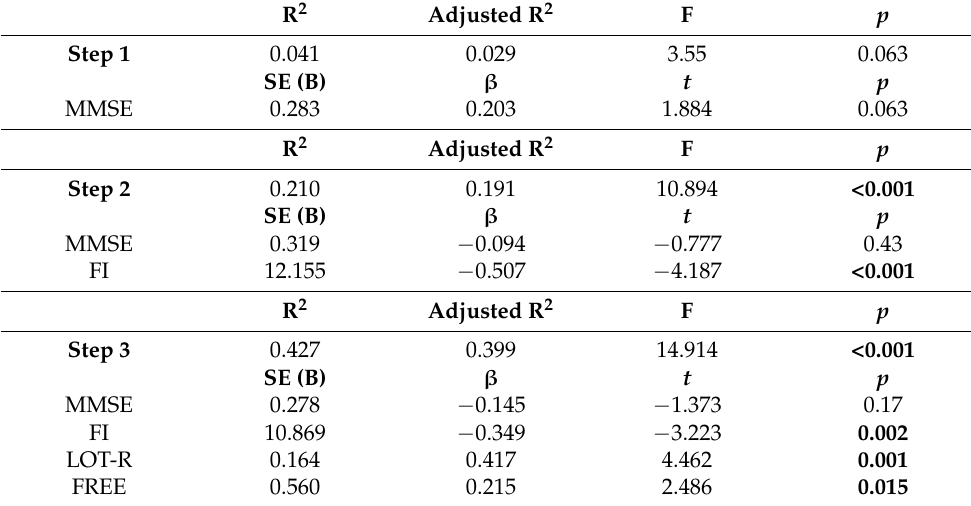
Table 5. Multivariate linear regression for MCS assessed at